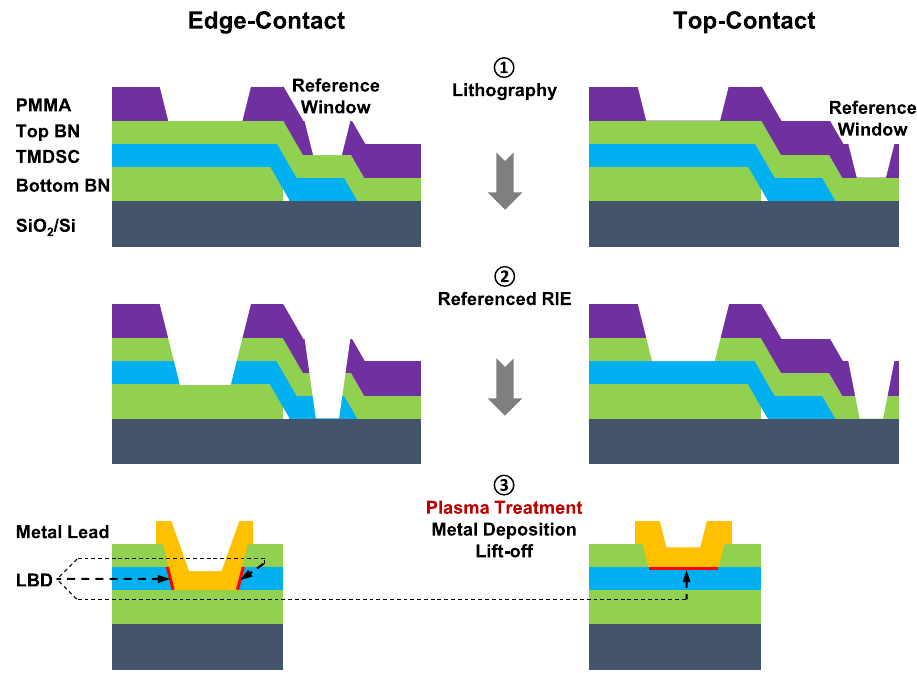
Fig. 2 Mechanism of the referenced RIE technique. Schematics showing the work fl ow of fabricating LBD contacts to BN-encapsulated TMDSCs in both edge- and top-contact geometries. After the soft oxygen plasma treatment, LBD appears on the exposed TMDSC edges or surface for the edge- and top- contact geometries,